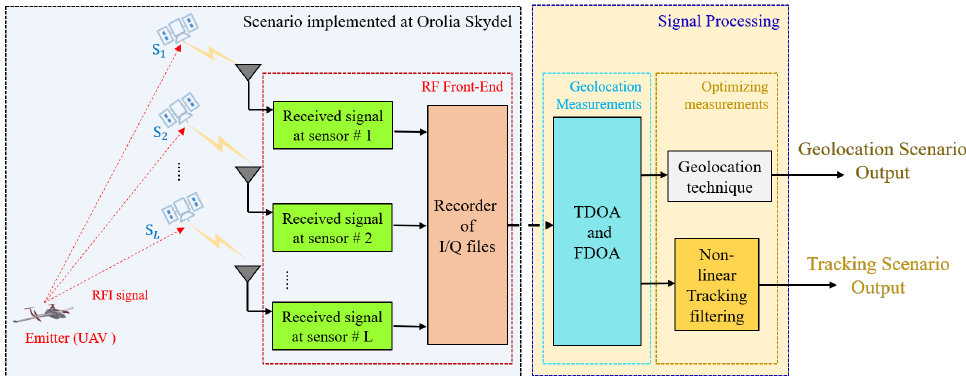
Figure 2. A general diagram of emitter estimation using multi-LEO satellites based on TDOA and FDOA